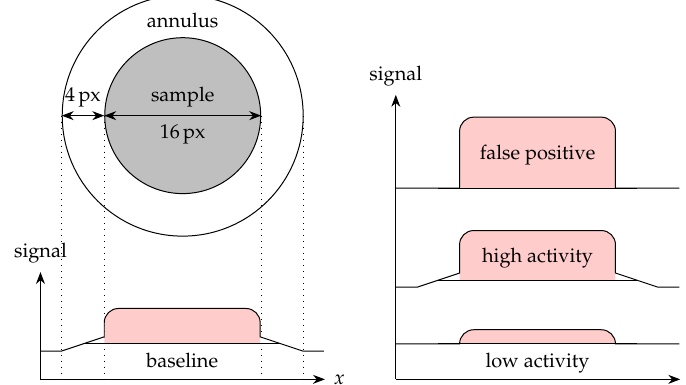
Figure 1. Scheme displaying the integration principle to obtain ∆ T values in ecIRT ( left ). Signals for three different sample categories ( right